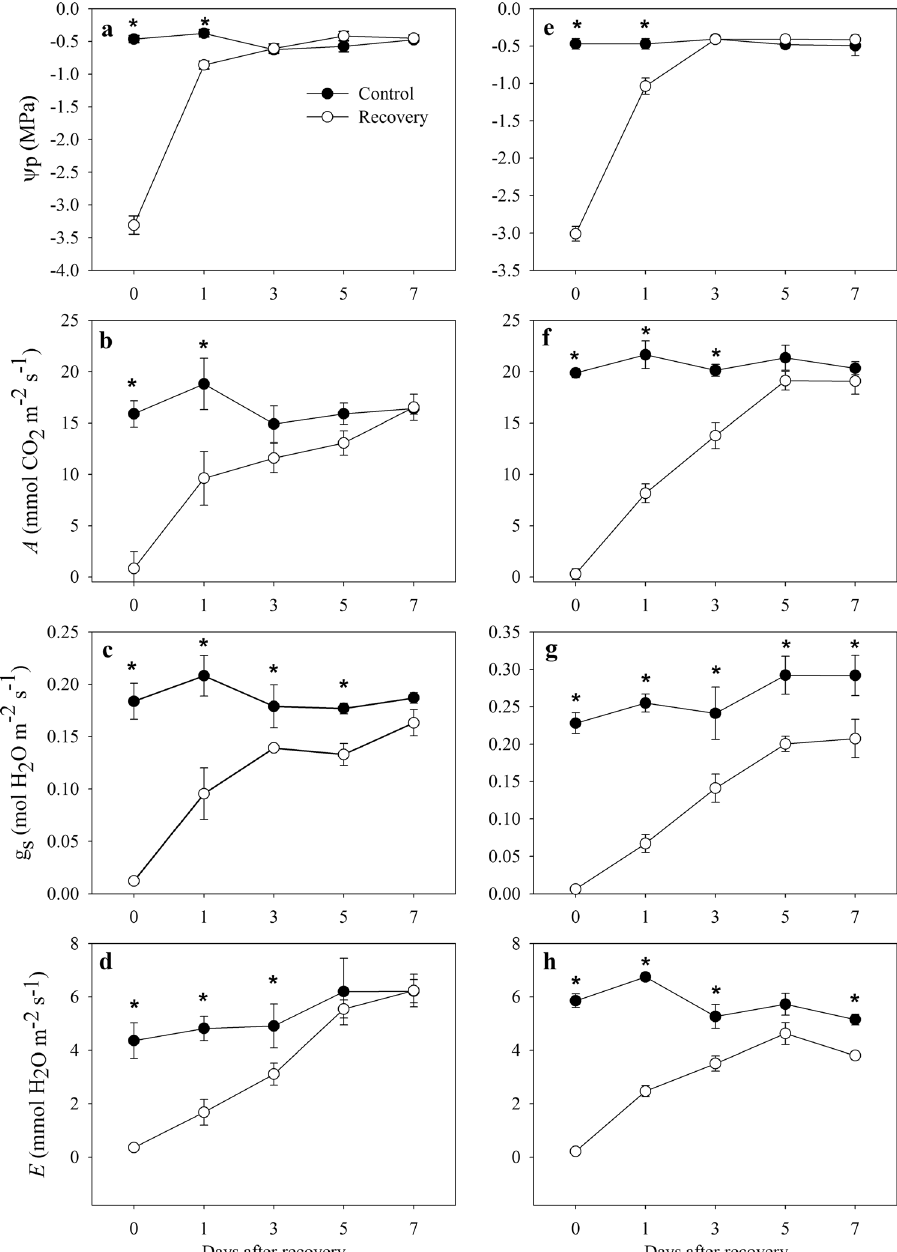
Figure 7. The Ψ p , g s , A and E on different days after re-watering following severe drought in A. fruticosa ( a , b , c and d ) and R. pseudoacacia ( e , f , g and h ). Asterisks indicate statistical significance at P < 0.05 between the control and recovery